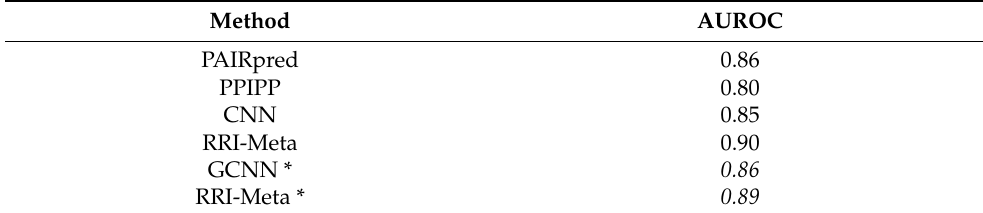
Table 1. Average results for LOOCV on DBD